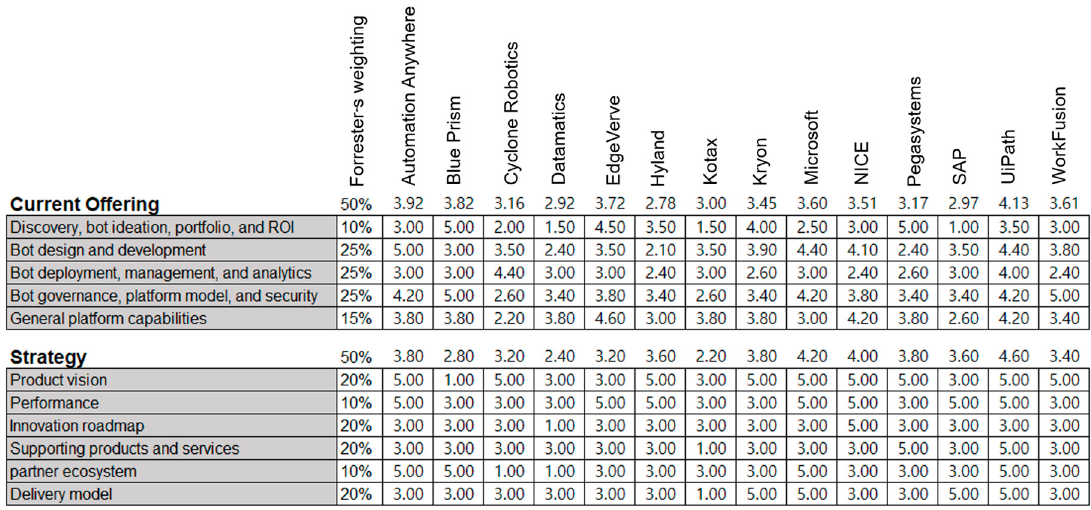
Figure 4. RPA scorecard (Q1 2021). Adaptation based on Ref. [24].